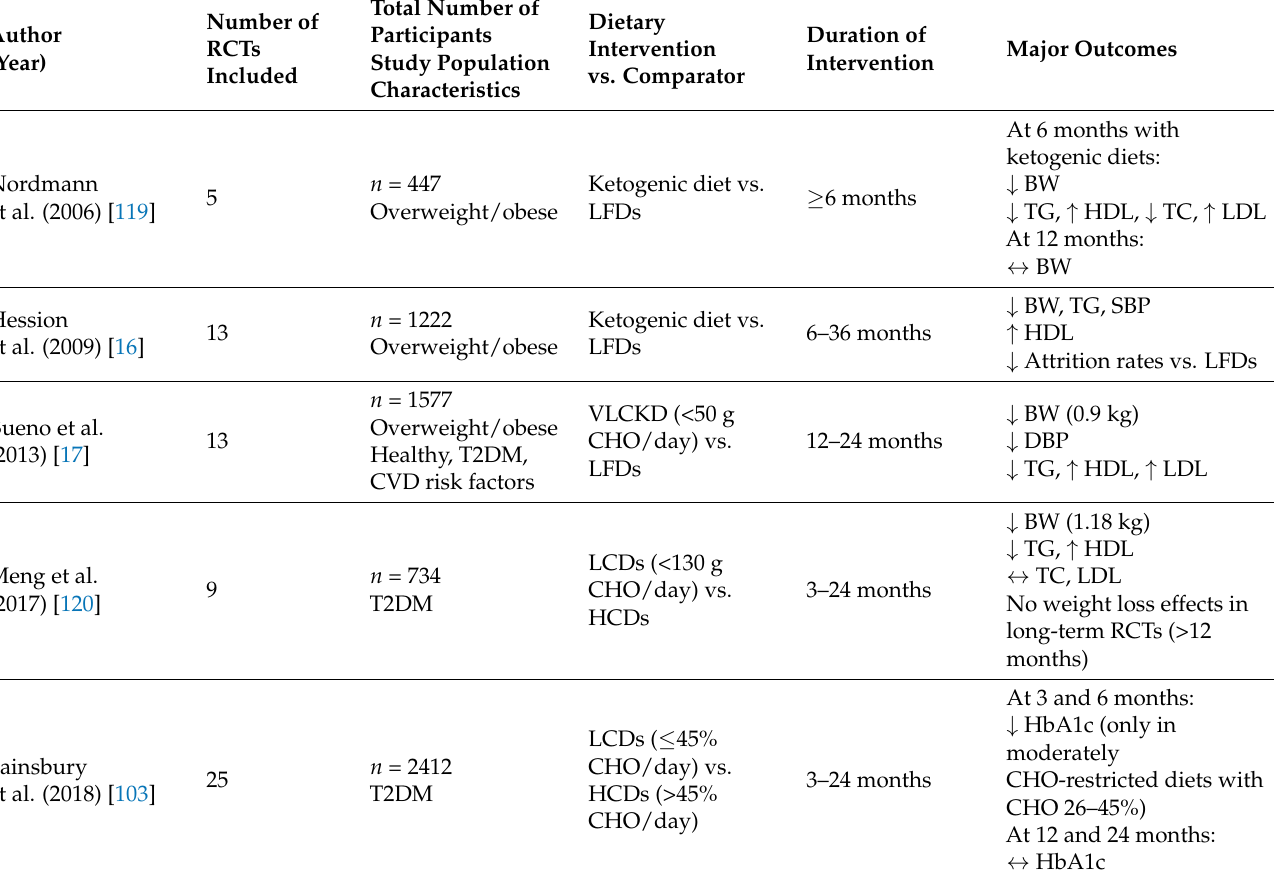
Table 4. A summary of the major meta-analyses of RCTs in the field of ketogenic diets in